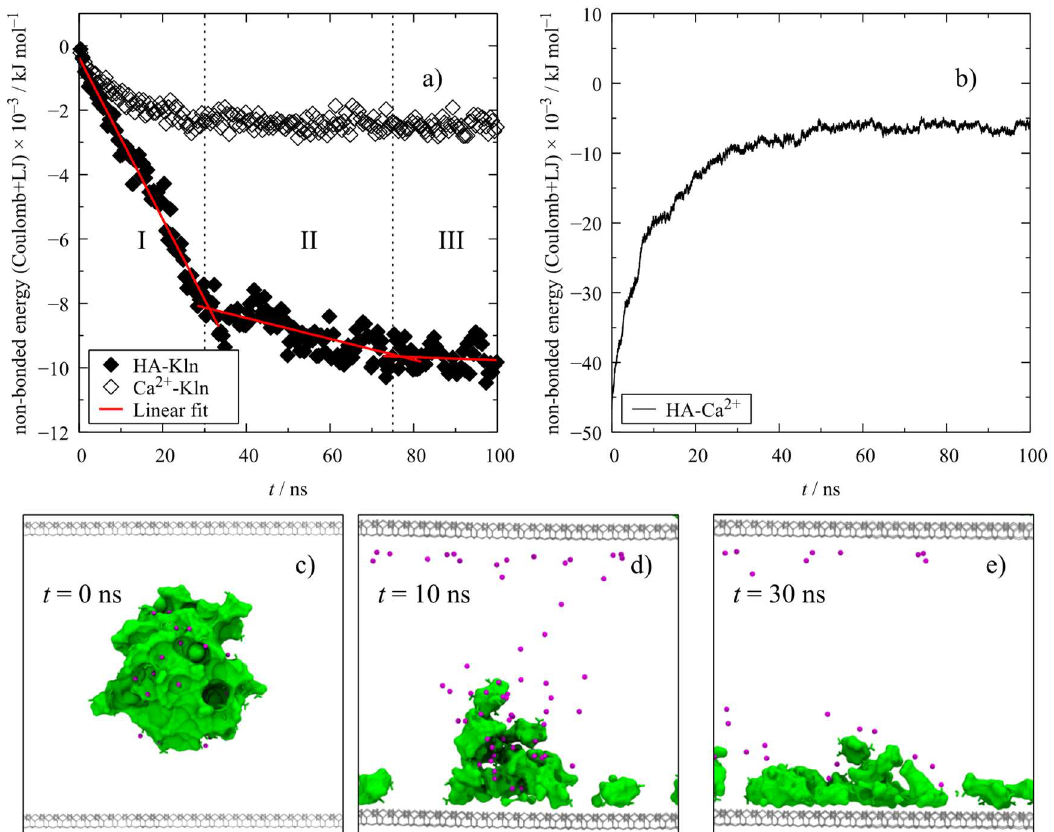
Figure 1. Time series of the non–bonded interaction energy (Coulomb + Lennard–Jones 12–6) in the equilibration step of kaolinite (Kln) with humic acids (HAs) and calcium ( a ); and HAs with calcium ( b ). The slope change indicates a different process. Side view ( xz –plane) of the dynamics of the HAs supramolecular structure (green isosurfaces) in the pore space between the two kaolinite surfaces (gray lines) at t = 0 ( c ), 10 ( d ), and 30 ns ( e ). Ca 2+ cations are represented as magenta balls. For clarity, water molecules are not shown. The top layer represents the periodic image of kaolinite.